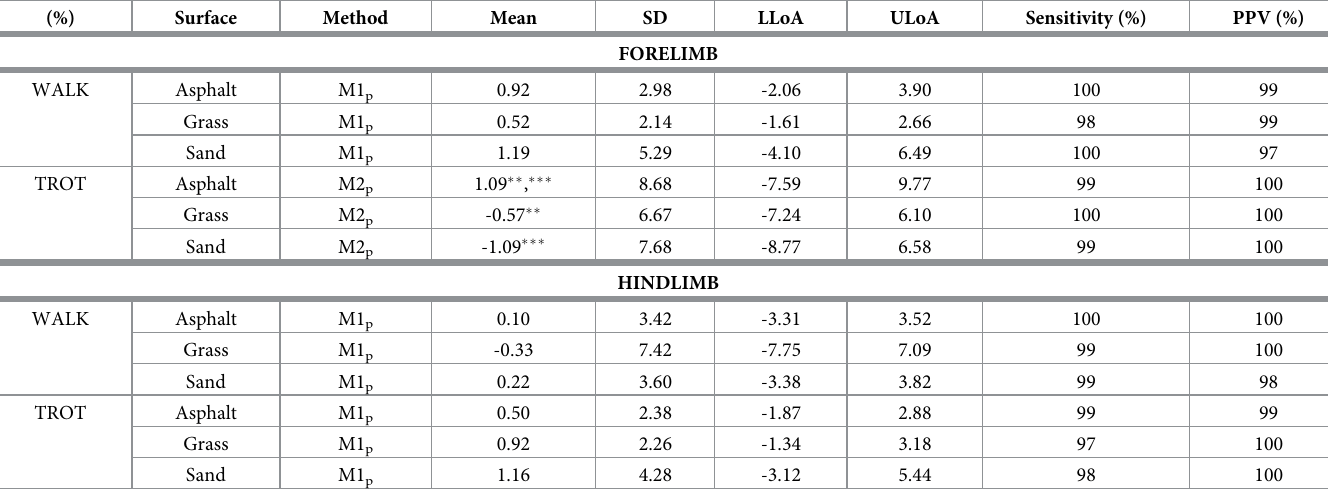
Descriptive statistics of the errors (as % of stride duration) incurred by the best methods to calculate stance duration; superscripts �� p < 0.01 and ��� p < 0.001 indicate where two mean errors differed significantly, as revealed by post hoc tests.